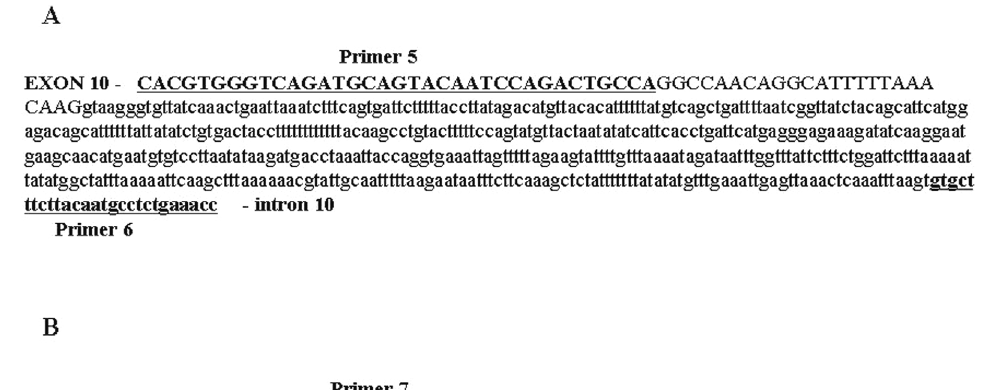
Figure 3. AhR gene intron 10 region sequences spanned by designed primer pairs P5-P6 and P7-P8. A , Primer pair P5-P6 spanning a 494-bp fragment (3’ end of exon 10-5’ end of intron 10). B , Primer pair P7-P8 spanning a 644-bp fragment (3’ end of intron 10-5’ end of exon 11). Exonic sequences are indicated in upper case and intronic sequences in lower case letters. Primer sequences are shown in bold. Ahr = aryl hydrocarbon receptor.